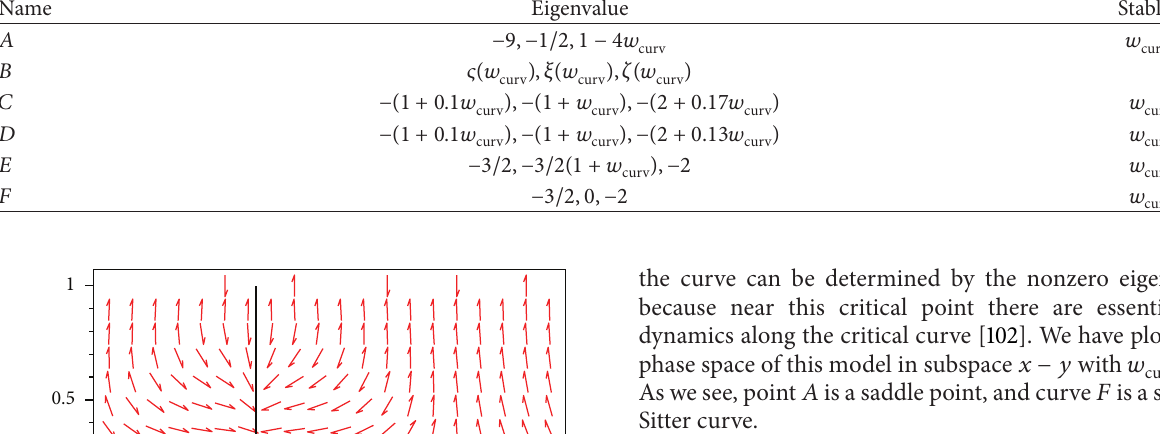
) , 𝜉(𝑤 ) , and 𝜁(𝑤 ) are complicated functions of 𝑤 curv curv curv